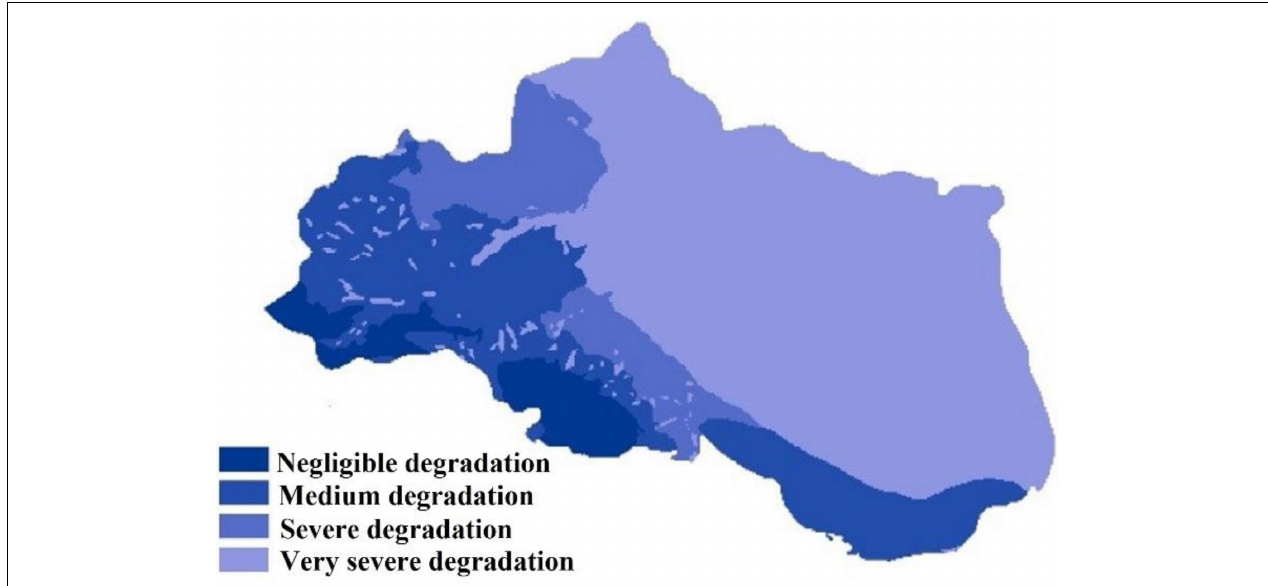
FIGURE 5 | Spatial distribution of the degradation classes across the basin.